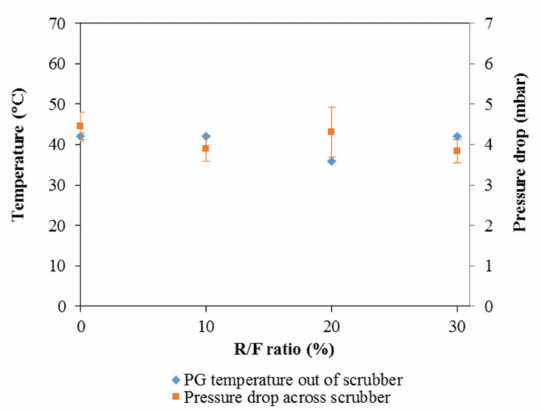
Figure 11. Influence of R/F ratio on the product gas (PG) temperature out of scrubber and pressure drop across the